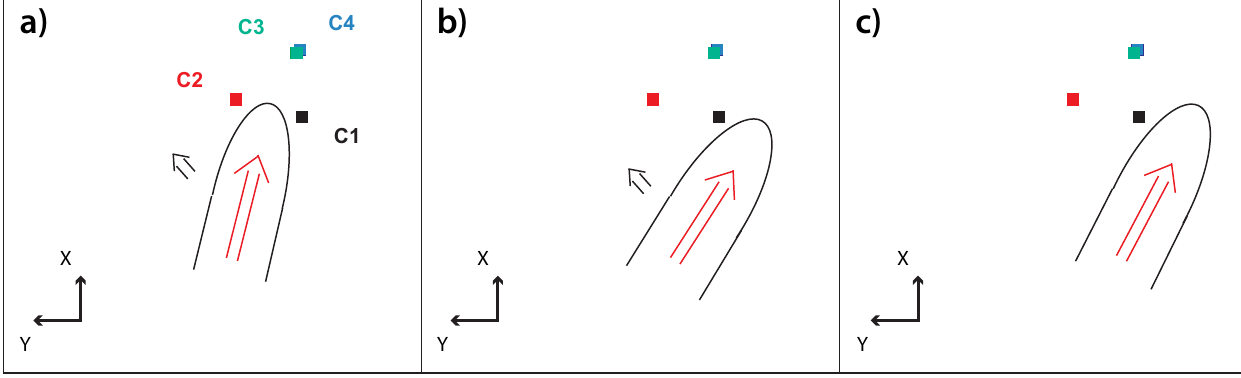
Fig. 6. Schematic illustrations for possible configurations of the BBF flow events in the GSM XY plane. Red and black arrows indicate the direction of the BBF proper flow and azimuthal drift direction of the flow channel, respectively. Frame (a) Event 1 at about 18:18UT when C2 observes the magnetic signatures on the duskside and C1 sees the dawnward return flow of the BBF. Frame (b) Event 2 at about 18:30UT when C1 encounters the BBF. Frame (c) Event 3a at about 18:41UT when C1 encounters the BBF. Note, that in this case no significant duskward motion of the flow channel was